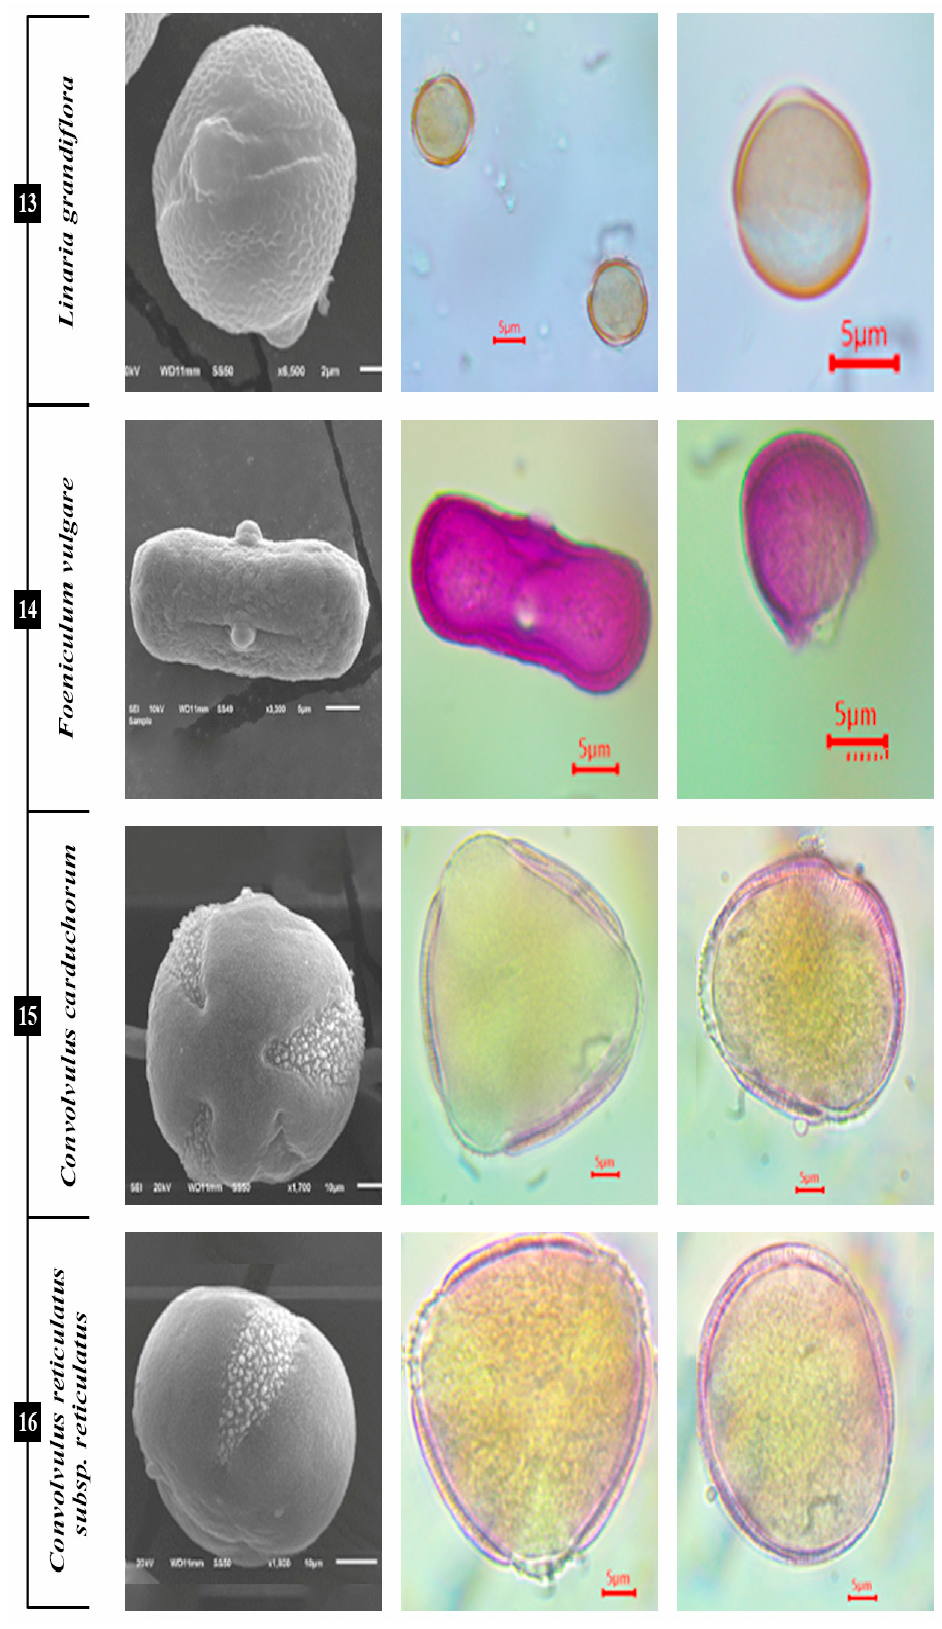
Figure 6. Scanning and light microscopic images of L. grandiflora , F. vulgare , C. carduchorum and C. reticulatus subsp. reticulatus.